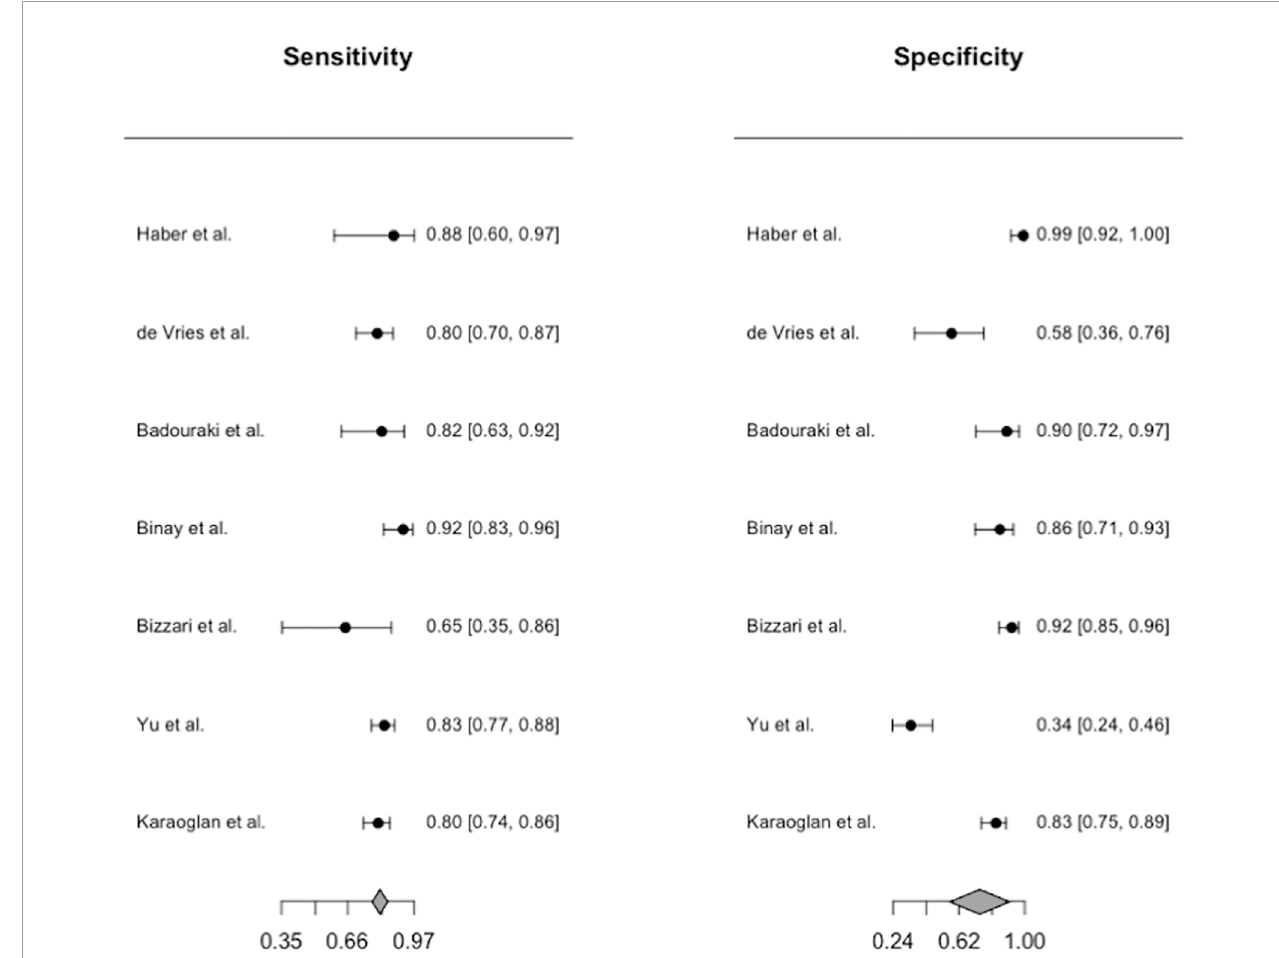
FIGURE 4 | Forest plots for the pooled diagnostic estimates of sensitivity and speci fi city of uterine